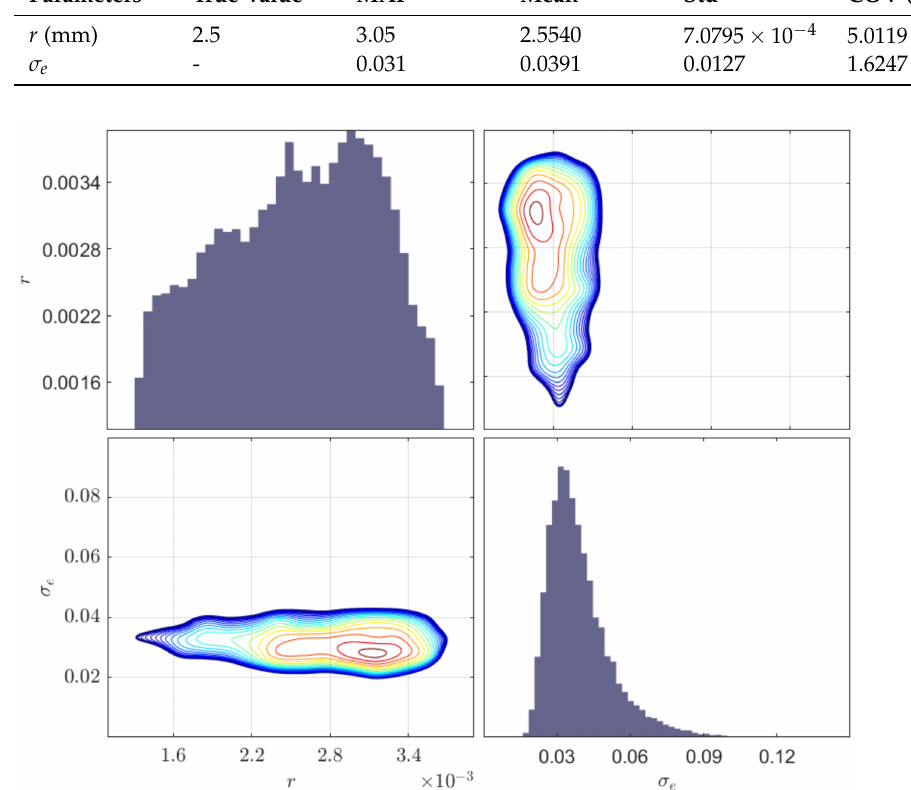
Figure 11. Posterior distribution of different parameters and contours of two − dimensional simulation densities inferred from physical experiments; the diagonal plots indicate the marginal distributions of the inferred